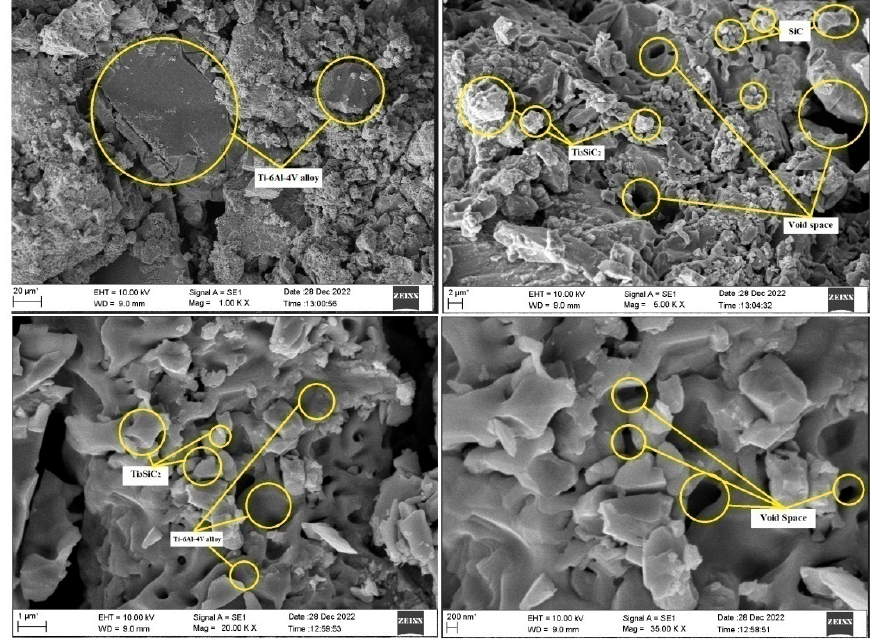
Figure 19. Scanning Electron Microscope images of Ti-6Al-4V-SiC(15 Wt.%) processed under aging temperature (1150 °C), aging time (four hours), heating rate (25 °C/min), and cooling rate (5 °C/min).